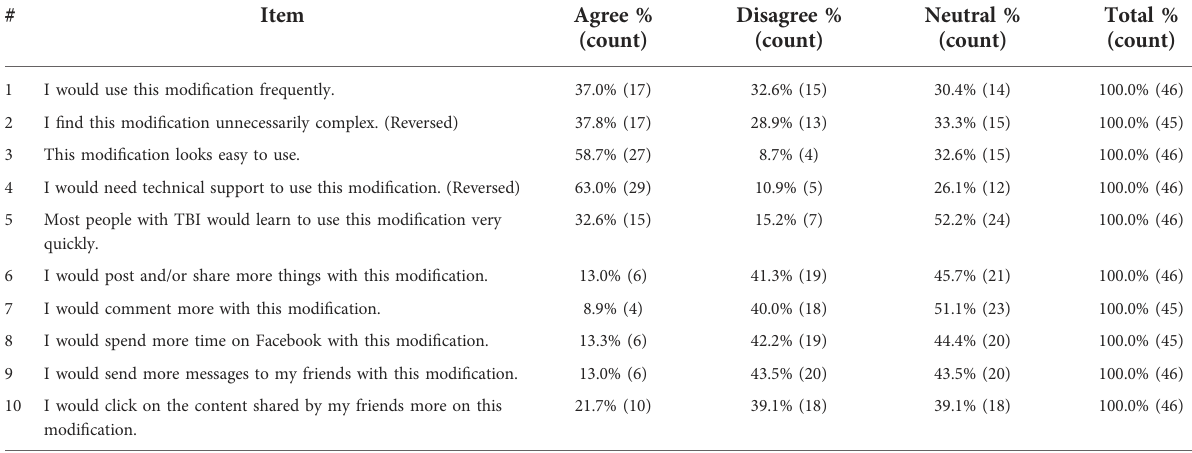
TABLE 4 Summary of participants ’ responses for memory aid. Item